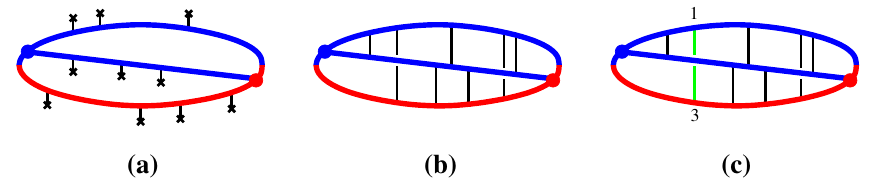
Figure 2 . (a) g → gg but now depicting interactions with the medium. Here, each black line ending in a cross represents an interaction of a high-energy particle with the gluon field in the medium. (b) The medium average of those interactions in the case of a weakly-coupled medium. Here the black lines represent 2-point correlations of the medium interactions, which dominate for a weakly-coupled medium. (The 2-point correlations can be written in terms of correlations h A a of the background gluon fields present in the medium.) The correlations are drawn as vertical in this time-ordered diagram because, in the high-energy limit, the correlation lengths in the medium are parametrically small compared to the length (time) scale of the high-energy splitting process. [Not shown but also present: short-time 2-point correlations between two medium interactions of the same high-energy particle.] (c) One correlation between particles 1 and 3 is